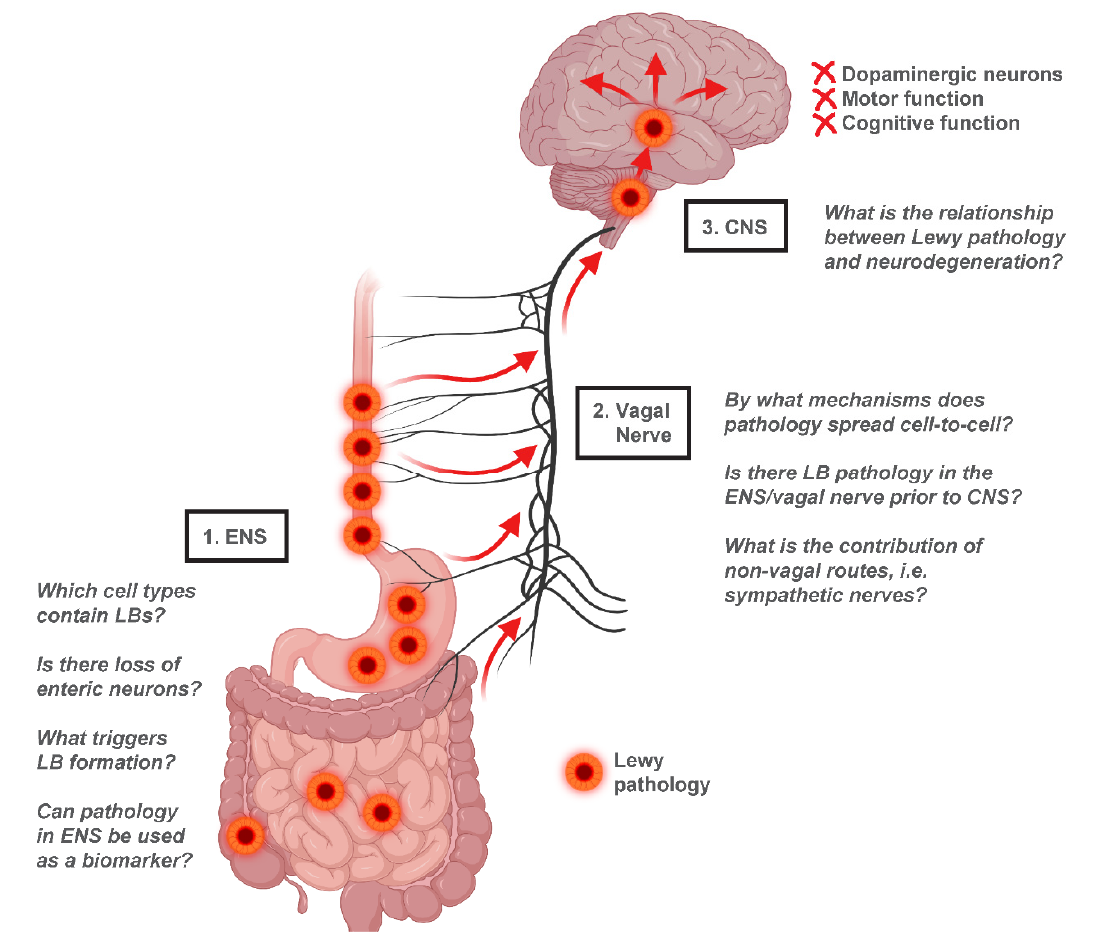
Figure 3. Gut-to-brain α -synuclein transmission hypothesis of PD. Evidence from human studies suggests that Lewy pathology in the ENS of PD patients is concentrated in the upper gastrointestinal tract, with the greatest LB density found in the esophagus and stomach. This distribution parallels vagal innervation of the ENS, consistent with a potential transmission of α -synuclein from the ENS retrogradely through the vagal nerve into the CNS. Once in the CNS, Lewy pathology appears to spread from the brainstem to the midbrain and finally to cortical regions, resulting in neurodegeneration and functional decline. Several unresolved questions relating to the gut-to-brain hypothesis of PD are highlighted. Figure created using Biorender.com.